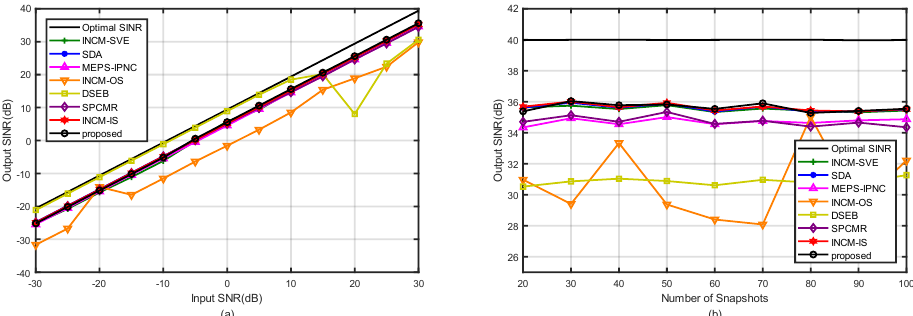
Figure 5. Output SINRs in the case of incoherent local scattering error versus ( a ) input SNRs with K = 100; ( b ) the number of snapshots with SNR = 30 dB.